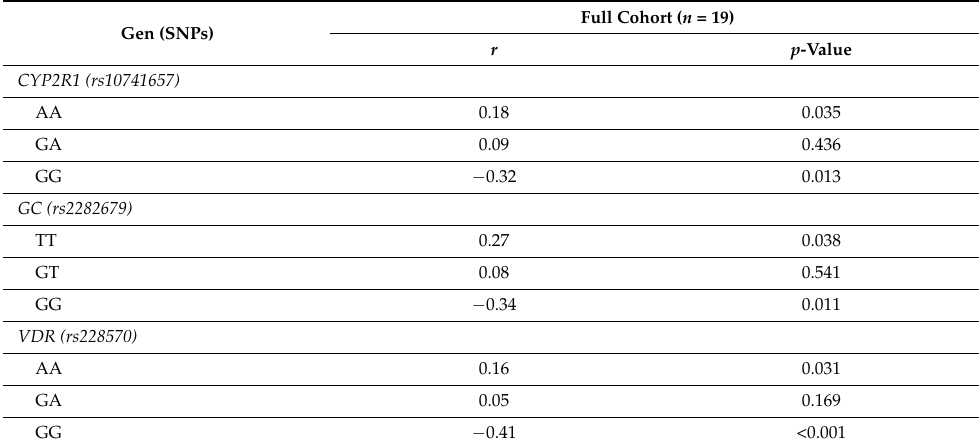
Table 5. Correlations between the concentration of 25-hydroxy vitamin D and single nucleotide polymorphisms involved with vitamin D.